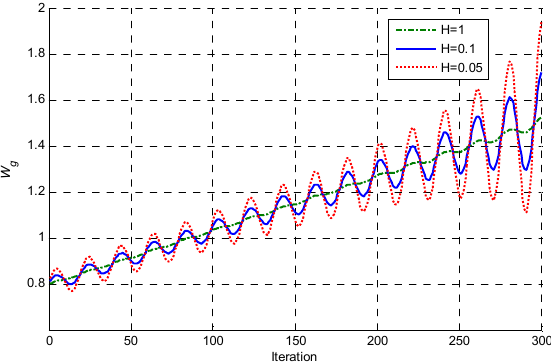
Figure 3. H of w g vs. different iterations.